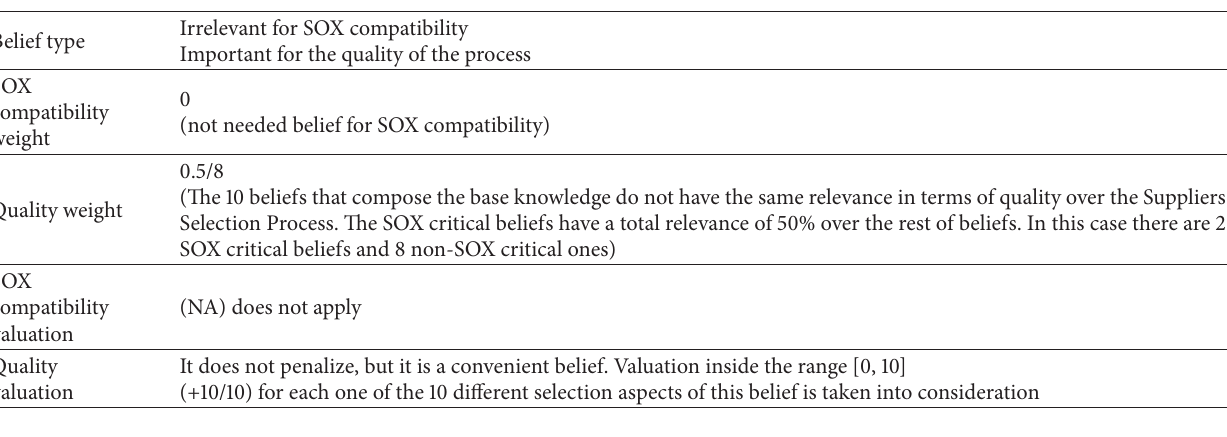
Table 7: Structure and Organization Scoring Protocol.